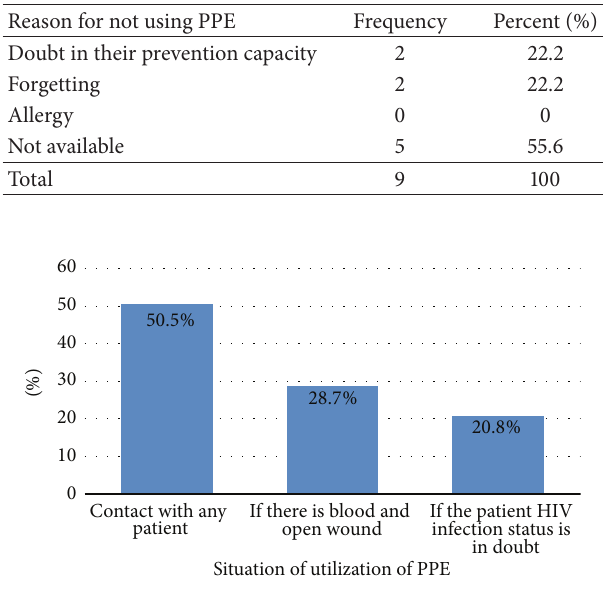
Figure 2: Situation of utilization of personal protective equipment by healthcare workers in Debre Berhan town, 2014.